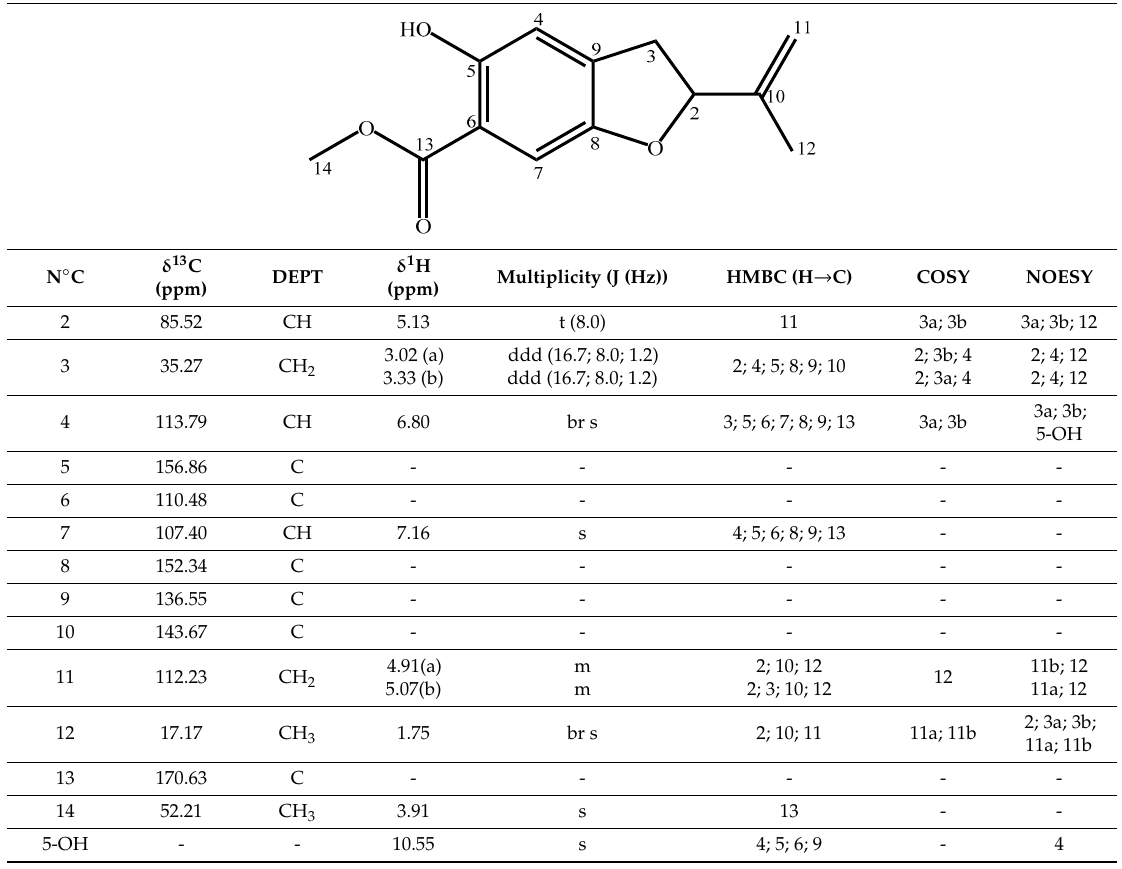
Table 1. Structure and NMR data of compound 1 .